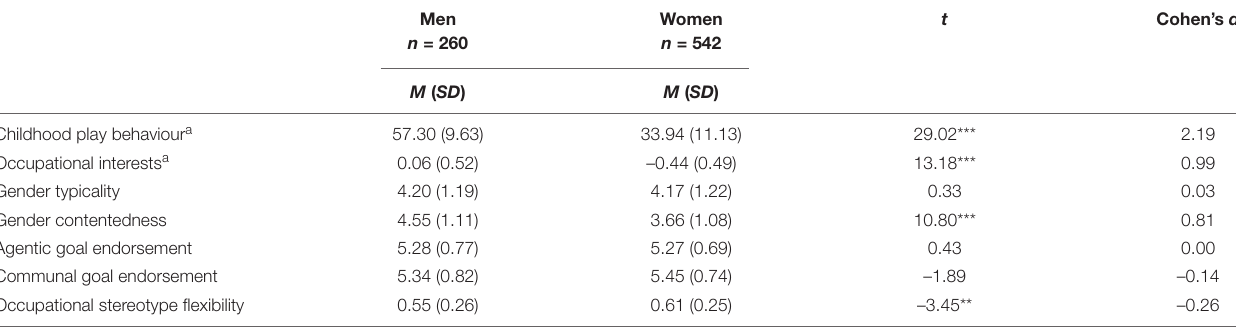
TABLE 1 | Gender differences in scores on the measures.